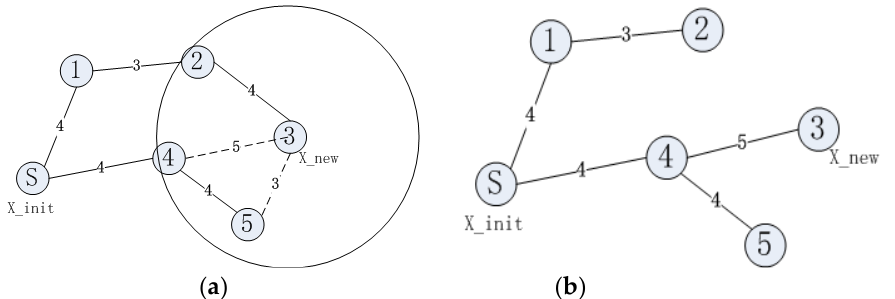
Figure 1. Principle of RRT* extension ( a ) Path planned by traditional RRT algorithm, ( b ) Opti- mized path.